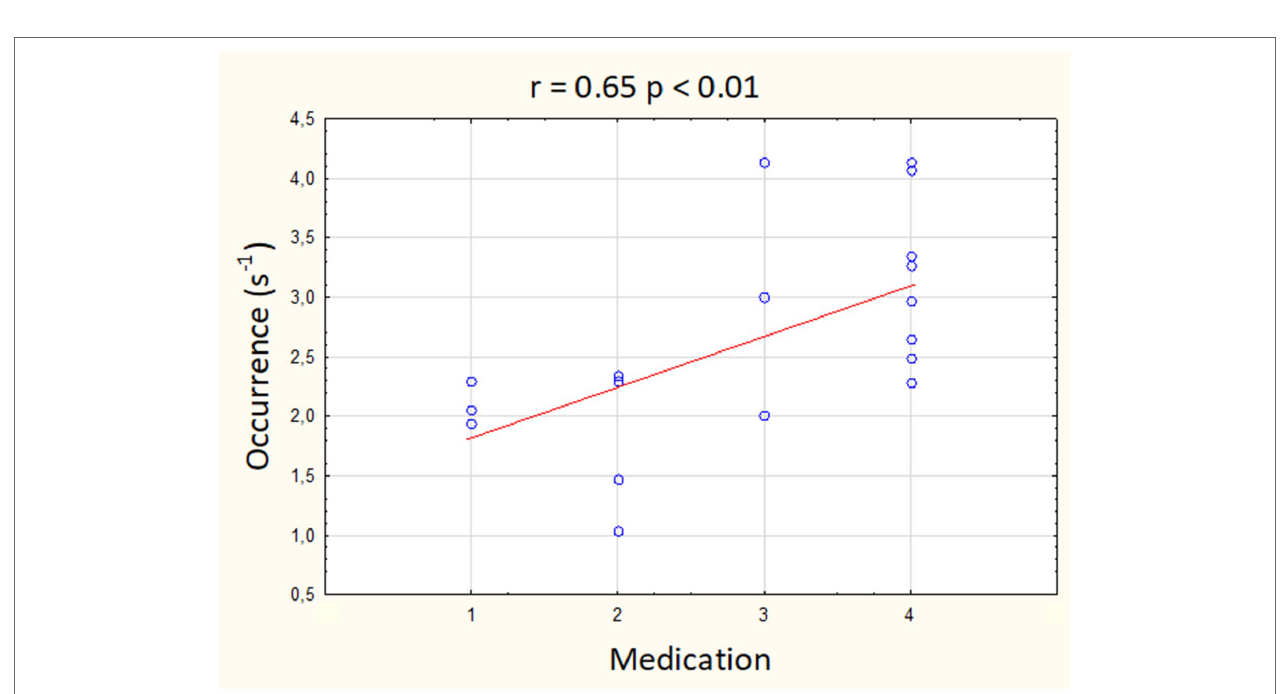
FIGURE 3 | Correlation between the occurrence of microstate A and Montgomery–Åsberg Depression Rating Scale (MADRS) score.